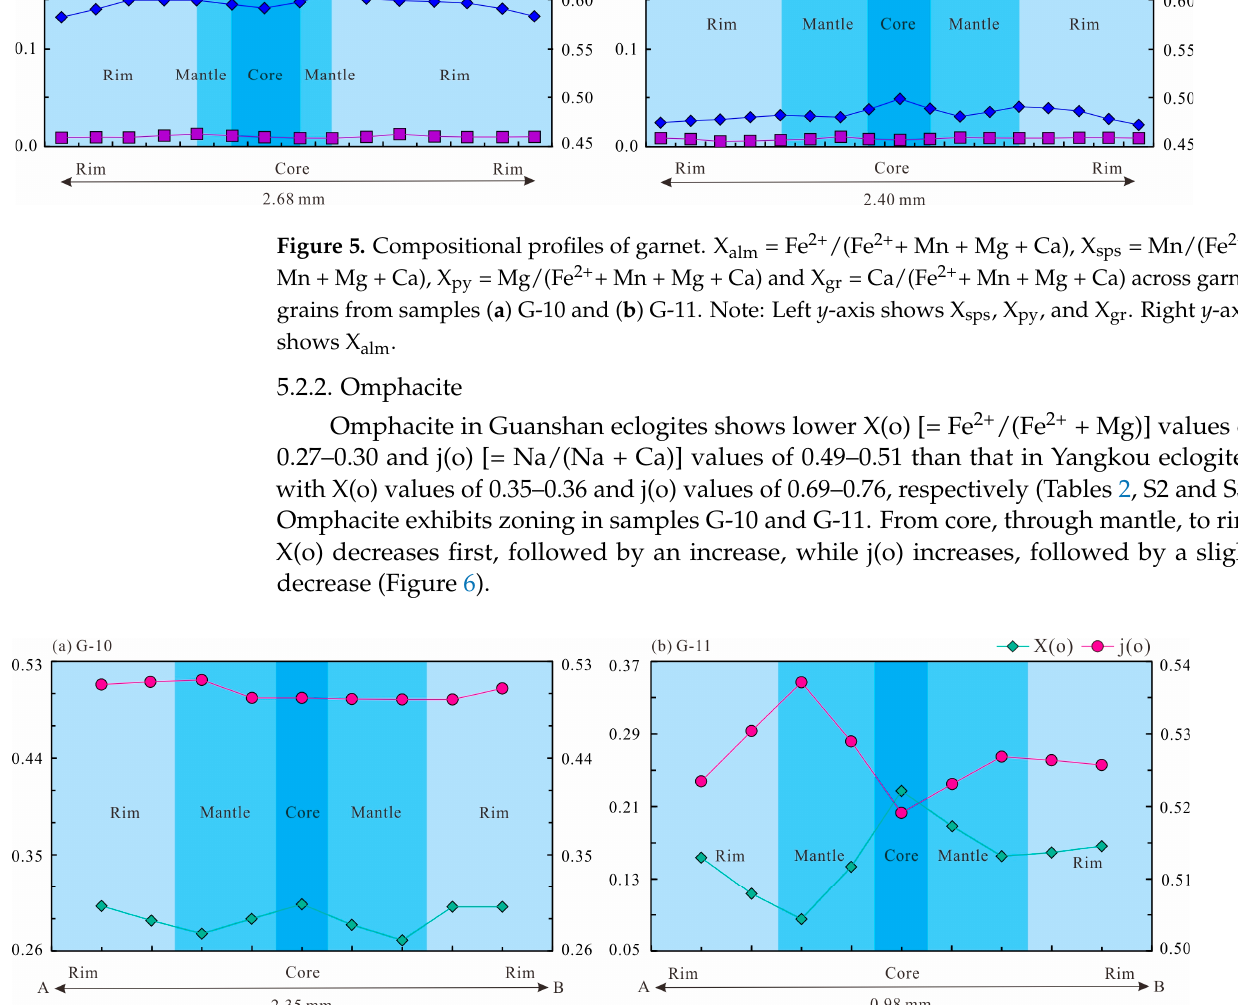
Figure 6. The composition zonings of X(o) = Fe 2+ /(Fe 2+ + Mg) and j(o) = Na/(Na + Ca) for omphacite from samples ( a ) G-10 and ( b ) G-11. Note: Left y -axis shows X(o). Right y -axis shows j(o).